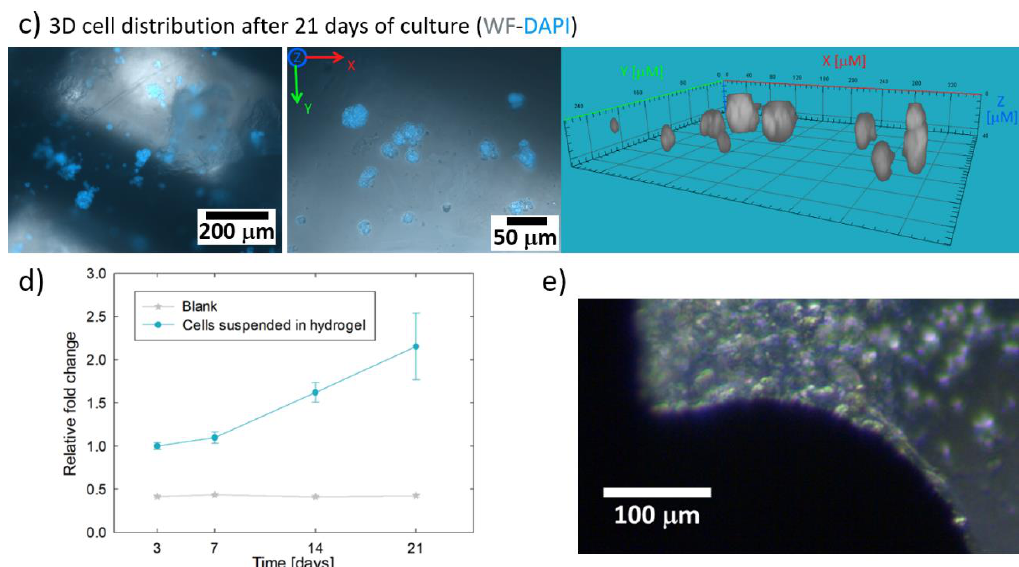
Figure 5. Culture of cells encapsulated in hydrogel inside beta tricalcium phosphate ( β -TCP) sca ff olds: ( a ) shape and microstructure of the β -TCP sca ff olds without cells, ( b ) images of the encapsulated Saos-2 cells growing in globular aggregates (pointed by arrows) inside β -TCP sca ff olds, ( c ) confocal microscope image stack (widefield (WF) (grey) and DAPI (blue)) and 3D virtual reconstruction of the cell aggregates after 21 days of culture, ( d ) cell metabolic activity expressed as relative fold change compared to the cell metabolic activity obtained on day 3 (n = 3), and ( e ) example of cells lining the surface of the sca ff old after 14 days of culture.